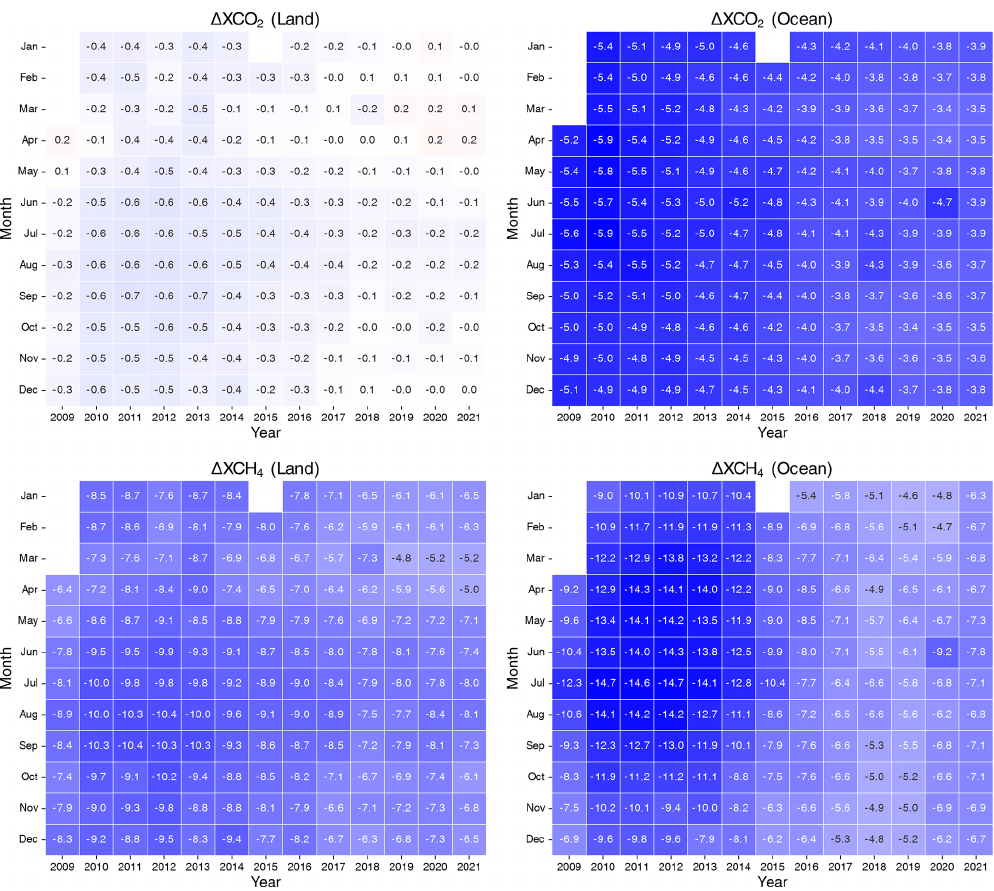
Figure 7. Time series heat maps of the differences in monthly mean XCO 2 and XCH 4 over land and the ocean between V02.90/91 and V03.00 (V03.00 minus V02.90/91). Only the observations commonly available for both versions were used. The units for XCO 2 and XCH 4 are ppm and